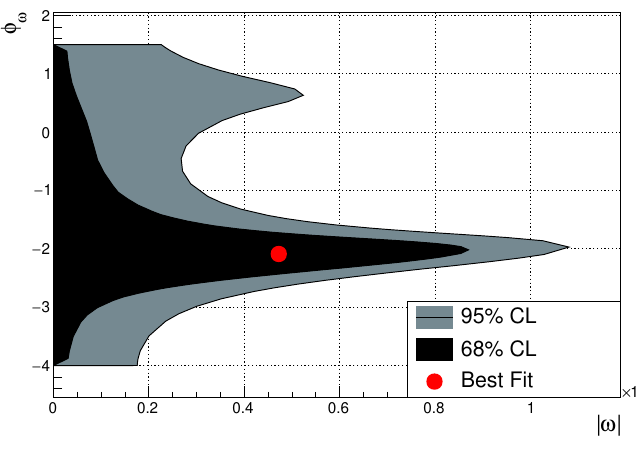
Figure 6 . Contour plot of φ ω vs. | ω | for 68% and 95% confidence